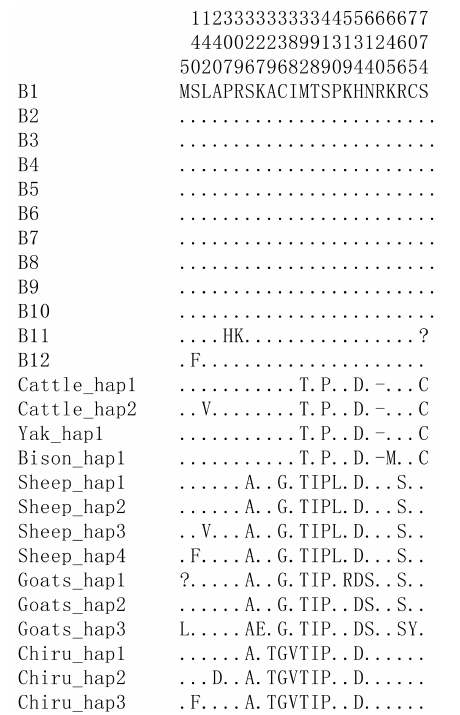
Figure 7. Phylogenetic tree constructed by using maximum like- lihood method (Hasegawa-Kishino-Yano model). Bootstrap confi- dences which are adjacent to nodes are based on 10000